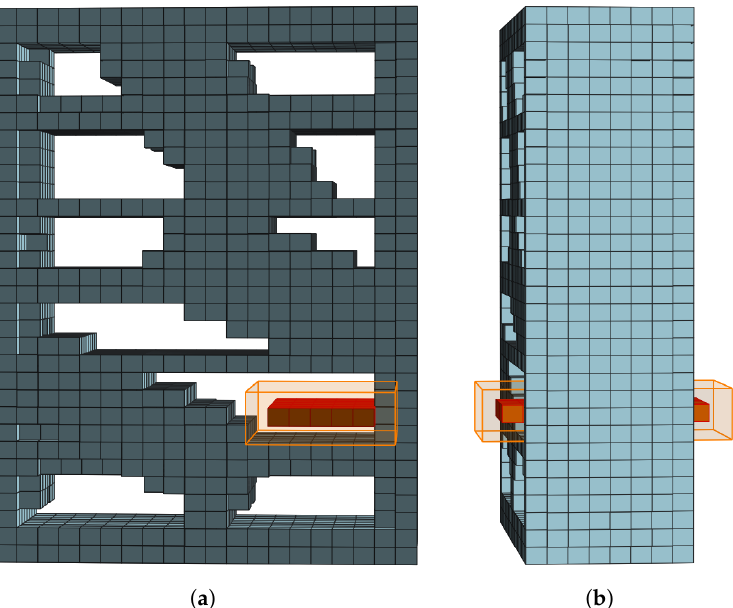
Figure 3. Rectangular free space core dilated by δ yields an empty storage volume candidate (orange bounding box): ( a ) Front view, ( b ) Side